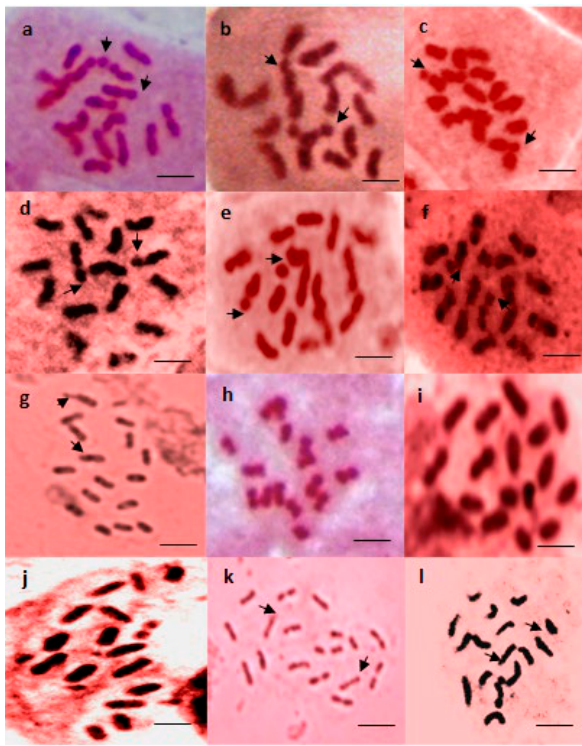
Figure 1. Mitotic metaphases of Algerian natural populations of Trifolium subterraneum L. with two chromosomes numbers 2n=16 and 2n=18 respectively: (a) population 12/10; (b) population 13/10; (c) population 19/10; (d) population 20/10; (e) population 22/10; (f) population 23/10; (g) population 25/10; (h) population 26/10; (i) population 33/10; (j) population 22/10 (2n=18); (k) population 25/10 (2n=18); (l) population 26/10(2n=18) . Arrows: satellites. Bar: